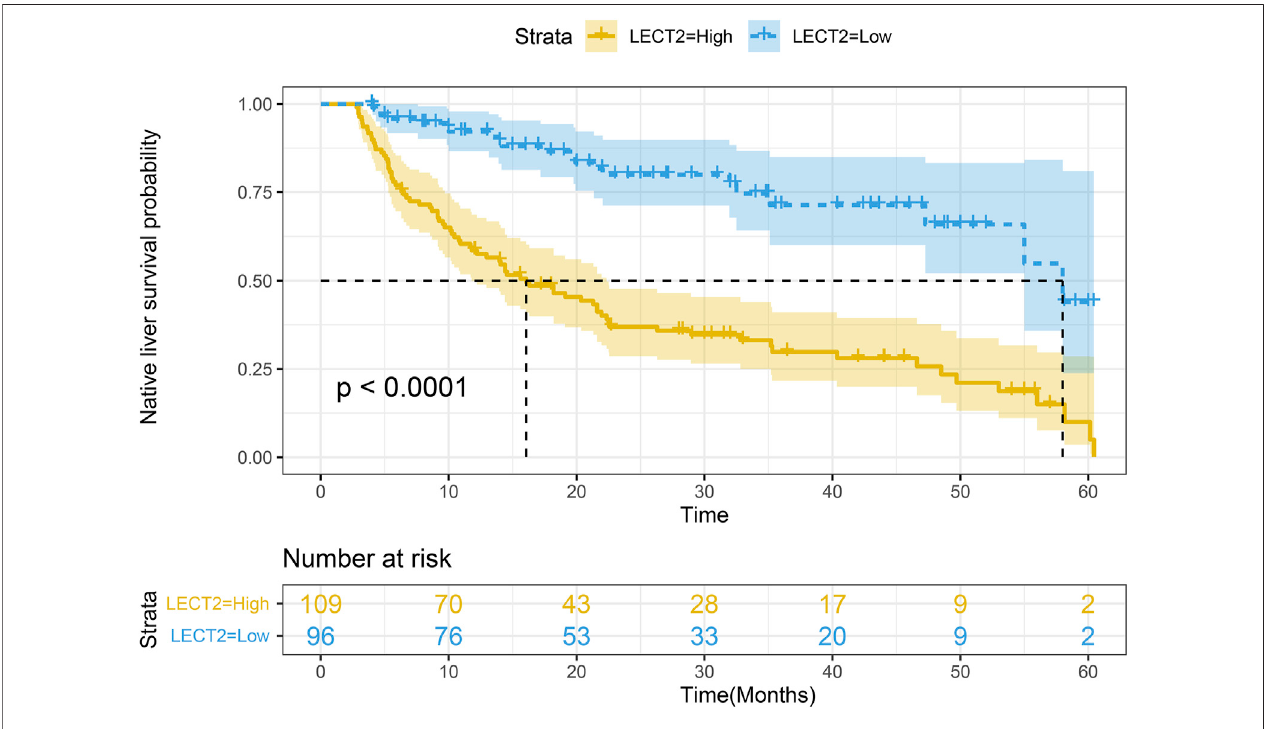
FIGURE 4 | Kaplan – Meier survival curves of native liver survival in biliary atresia.